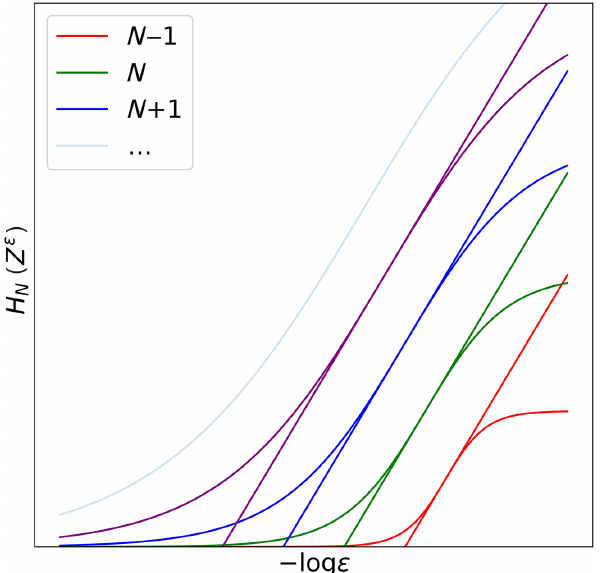
FIG. 11. Information dimension of the geometric quantum state of a qubit interacting with a 1 D environment with a defec- tive (i.e., nontranslation invariant) Heisenberg model of pro- gressively increasing size; see Eq. (14). The entire system is in its ground state | GS ( N ) (cid:3) , where the environment size is N ∈ [10, 22]. Each N yields a geometric quantum state whose infor- mation dimension we estimate using the box-counting algorithm explained in the text, extracting the slope using a linear fit for H N [ Z (cid:11) ]. Inset: a collection of all the data, together with the lin- ear fits. Overall: the collection of horizontal lines displays all M = 13 estimates and extracts the average and standard devi- ation. The result yields D ( 1 ) ∞ = 0.83 ± 0.02. The shaded areas in green, red, and blue correspond to the areas covered by fluctu- ations around the average of sizes σ , 2 σ , and 3 σ , respectively, where σ = 0.02 is the standard deviation of the sample of